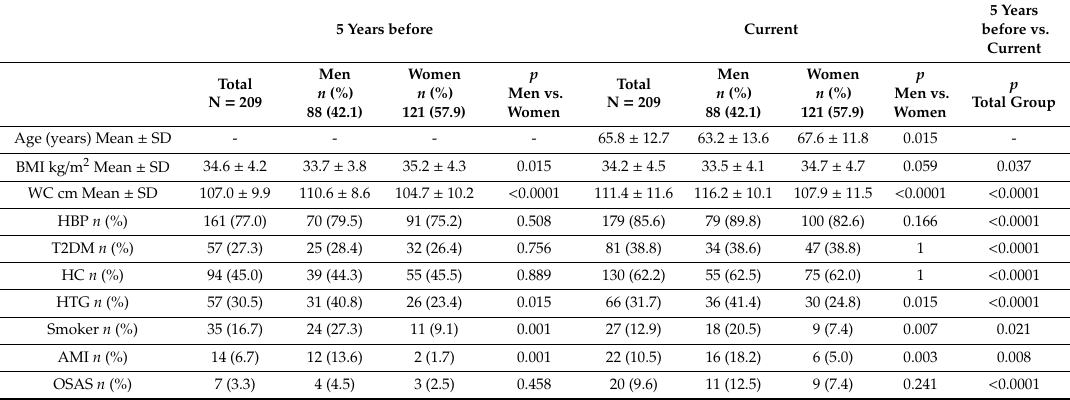
Table 2. Change in patients’ clinical status over studied time (five years).